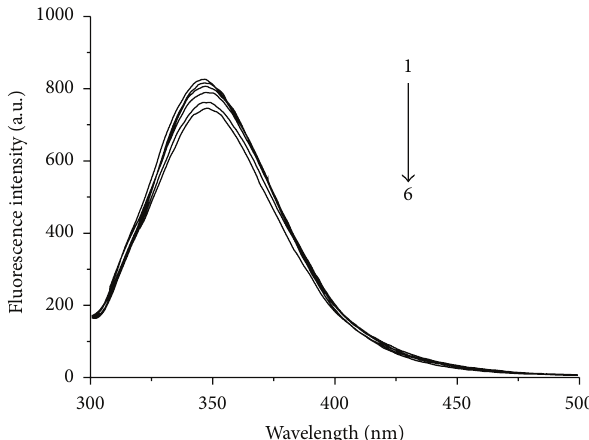
Figure 2: Fluorescence quenching spectra of BSA in presence of different concentrations of TRES. 𝐶 ( × 10 −7 mol L −1 ) (1–6): 0, 3, 6, 12, 18, and 24, respectively; 𝜆 280 nm; 𝑇 = 302 K.